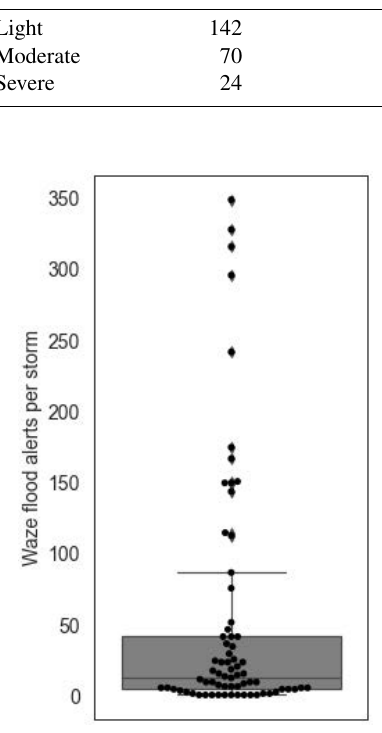
Figure 11. Total number of flood-related alerts per